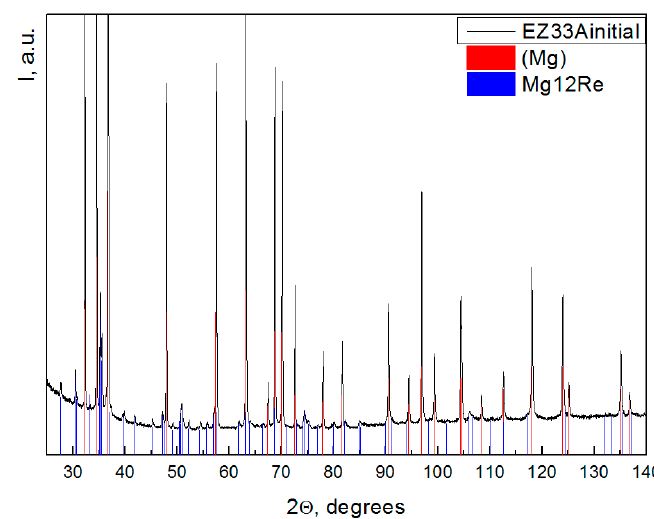
Figure 2. The X-ray diffraction (XRD) pattern for the as-cast EZ33A sample. According to the computer analysis the XRD resolves only two different phases, the matrix α -(Mg) solid solution phase and the second Mg 12 RE phase.